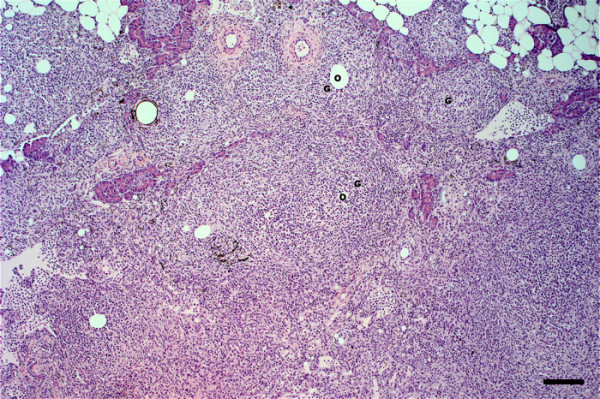
Severe inflammatory reaction at injection-site of Atlantic salmon at 12 weeks following injection. A severe granulomatous reaction with diffuse granulomas (G) induced by vaccine containing 6× standard M. viscosa antigens (FO-8). O- negative impression of oil droplets. Bar = 100 μm.